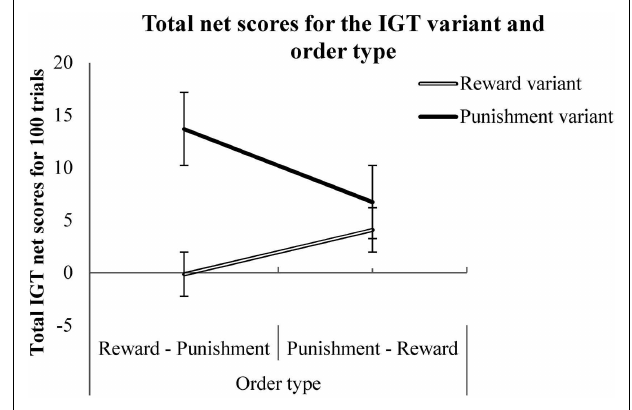
FIGURE 2 |Total net scores on the reward and the punishment variants (within-subjects) with the order of task presentation (between subjects). Error bars represent standard